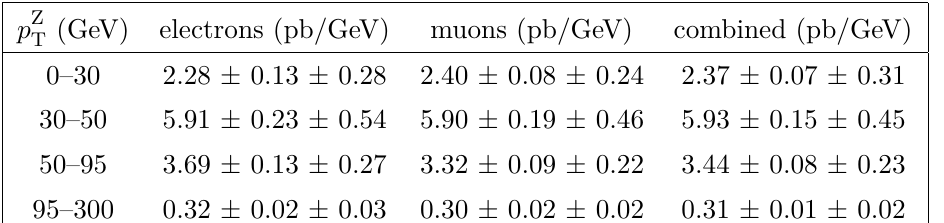
for electron and muon channels T